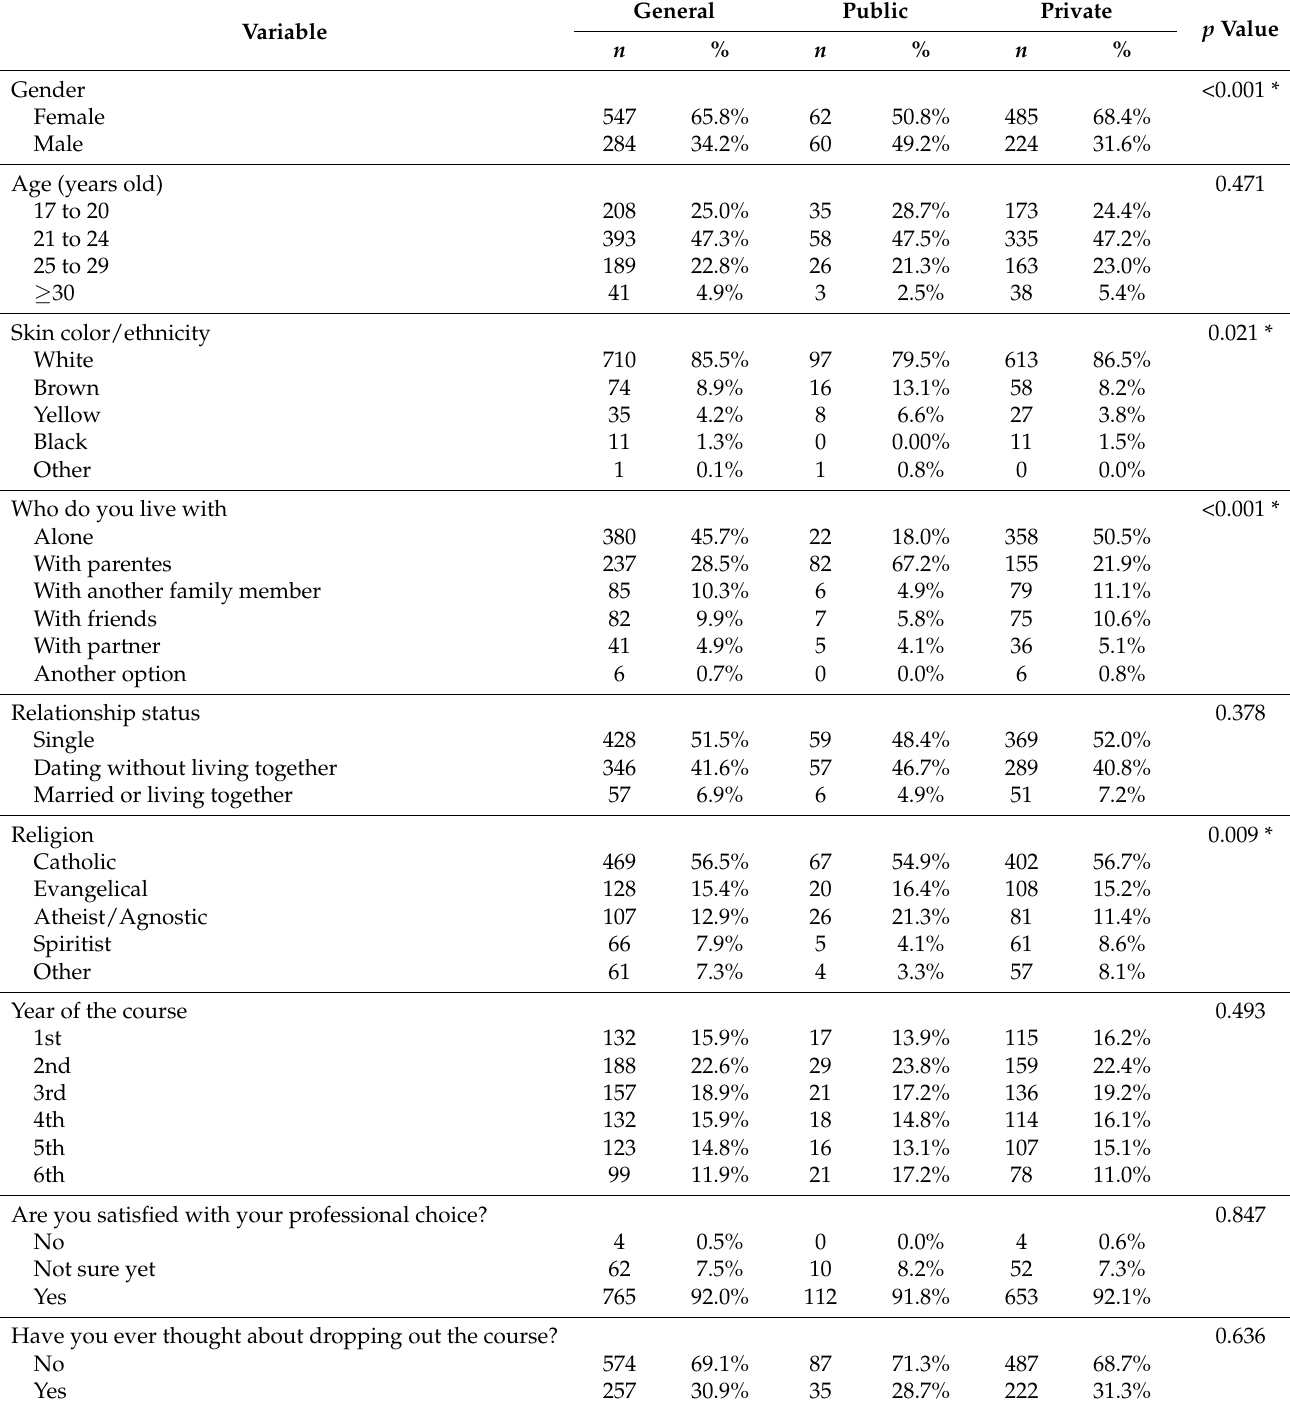
Table 1. Frequency distribution of the characteristics of the research participants, by